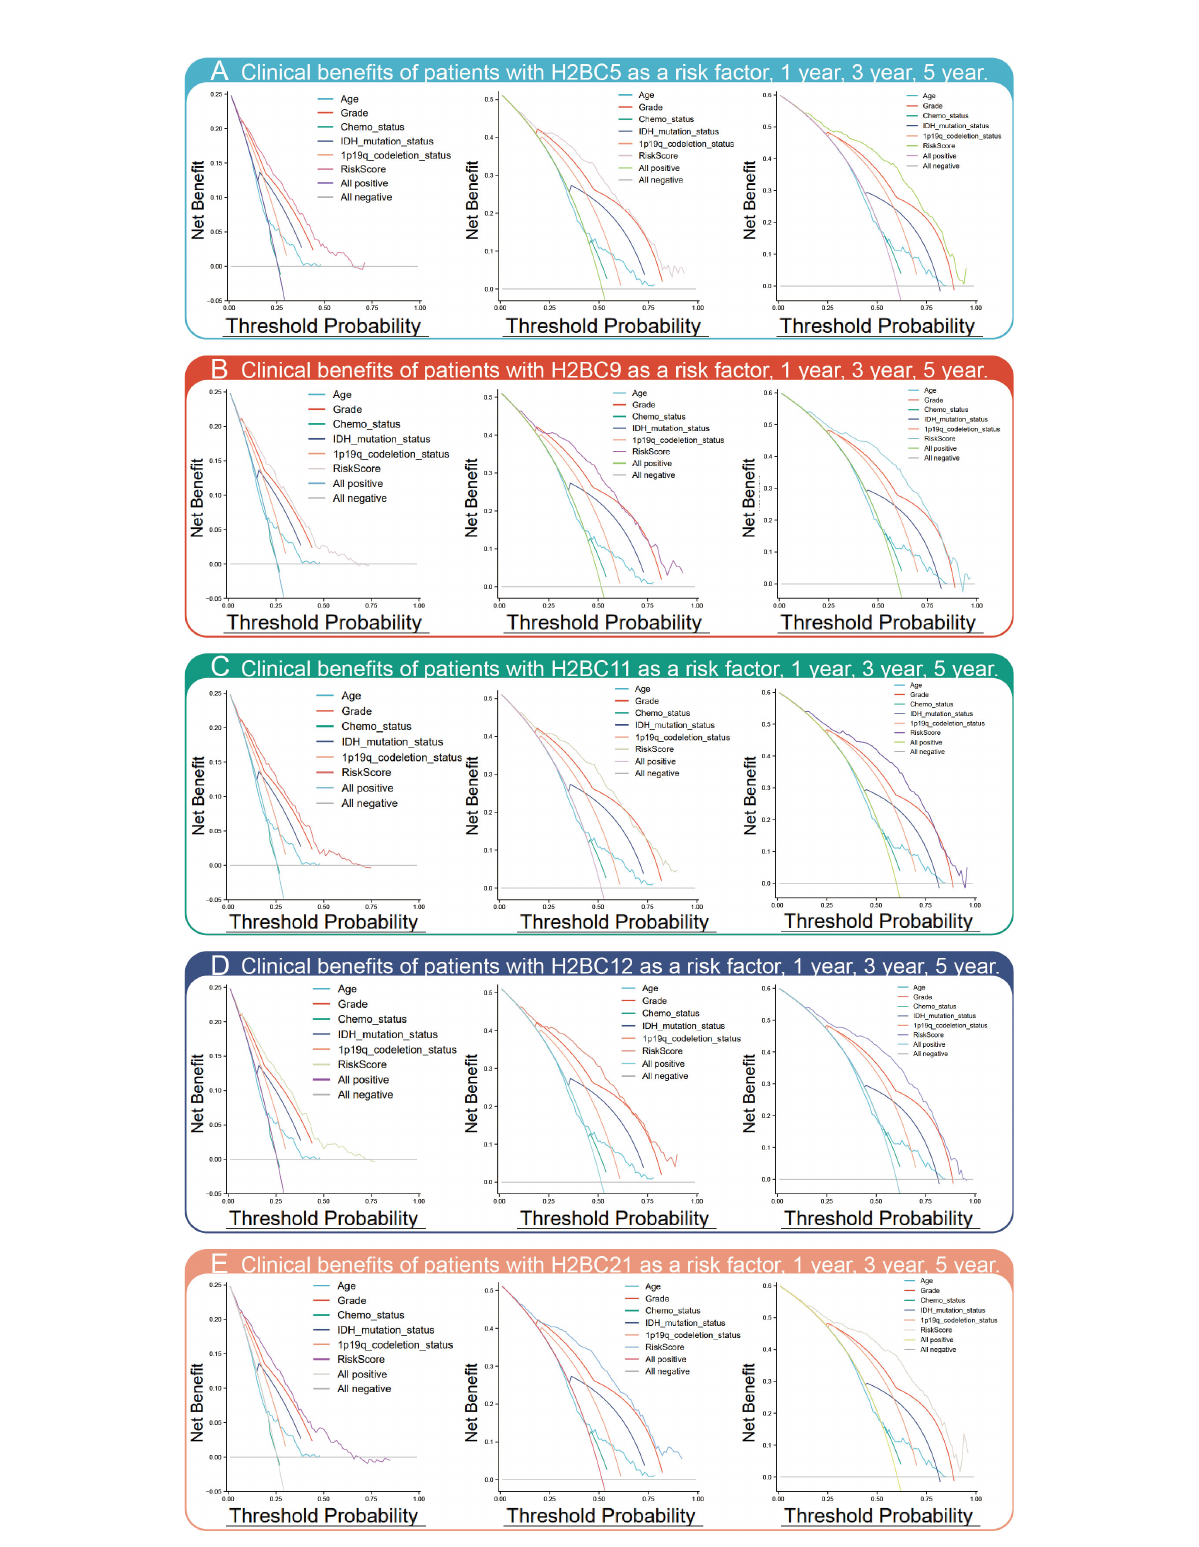
FIGURE 4 DCA chart of clinical bene fi ts. DCA assesses the clinical bene fi t (In this study refers to the mortality rate) of each risk factor, including (A) H2BC5, (B) H2BC9, (C) H2BC11, (D) H2BC12, and (E)